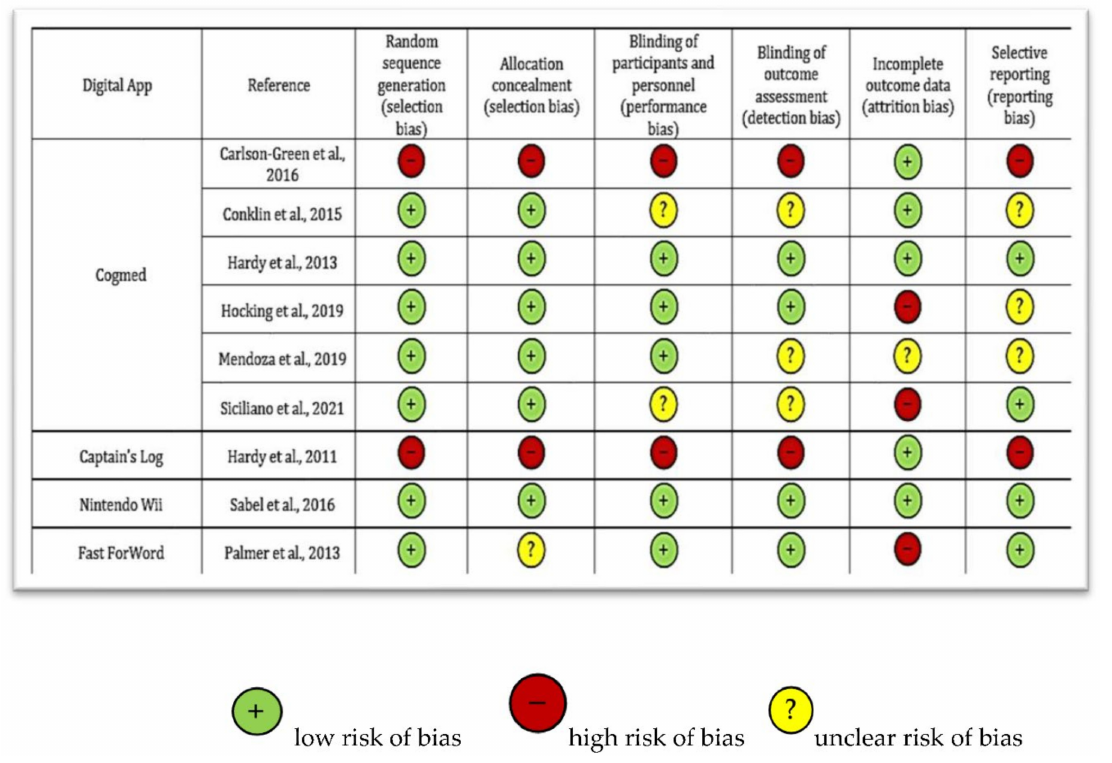
Figure 2. Qualitative assessment of the included studies through Cochrane Risk of Bias tool